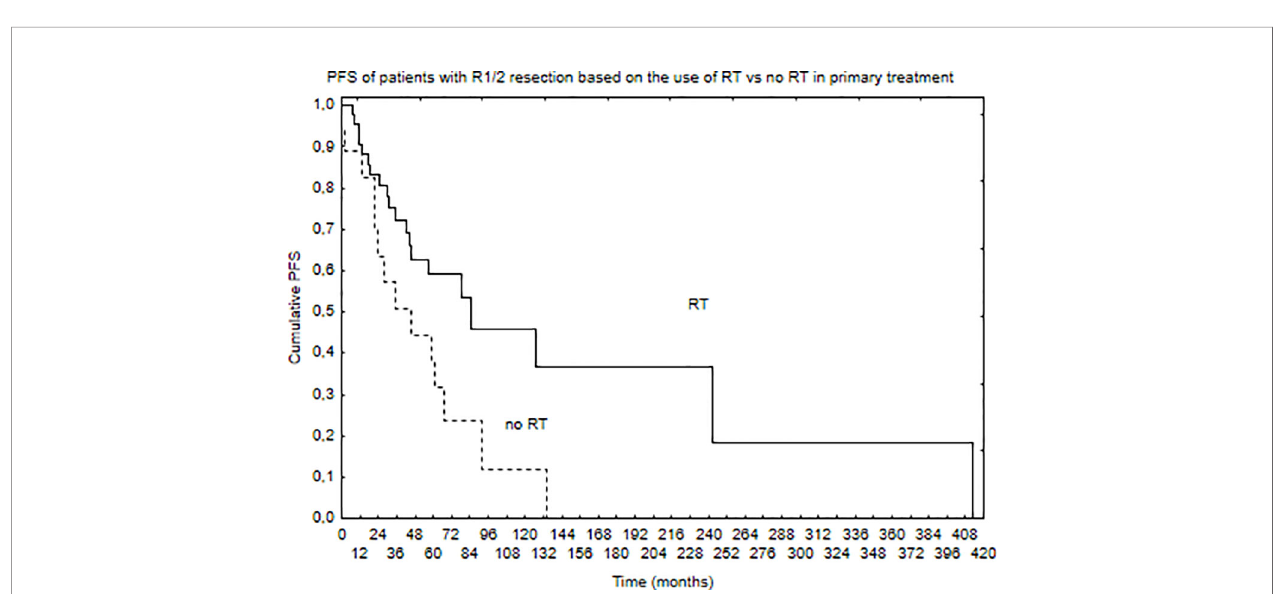
FIGURE 3 | Progression-free survival of patients with STR (R1 or R2 resection) of the tumor based on the use of RT in primary treatment ( p = 0.02).